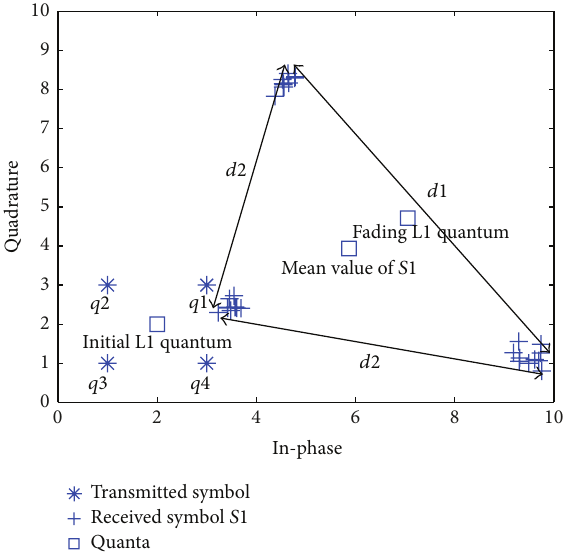
Figure 3: LC in square 16QAM constellations (first quadrant).